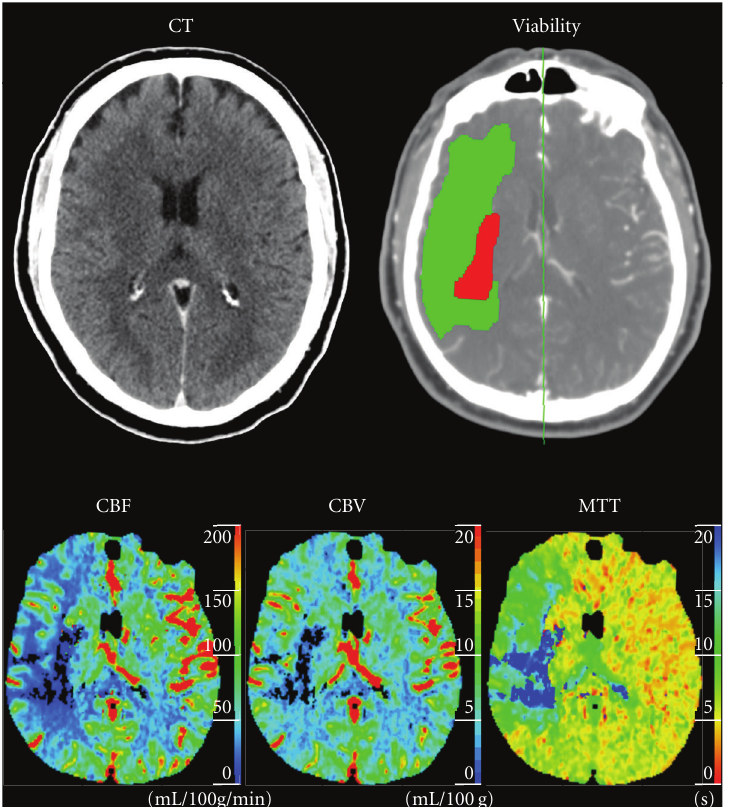
Figure 2: Case 1: Repeated NECT and CTP examinations 90 minutes after IV-thrombolysis without clinical improvement. The NECT is still normal and the CTP shows unchanged ischemic core but moderate enlargement of the penumbra. Based on this information the patient underwent intraarterial